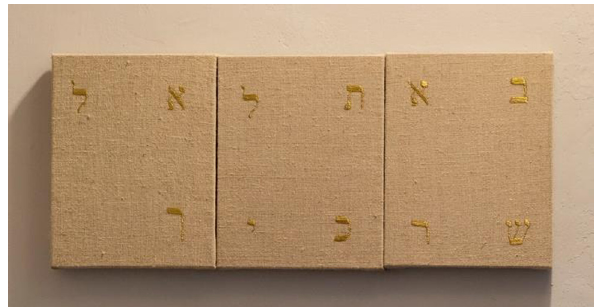
Figure 11: Leor Grady, Untitled ( For Where You Go, I will Go ) , 2019.